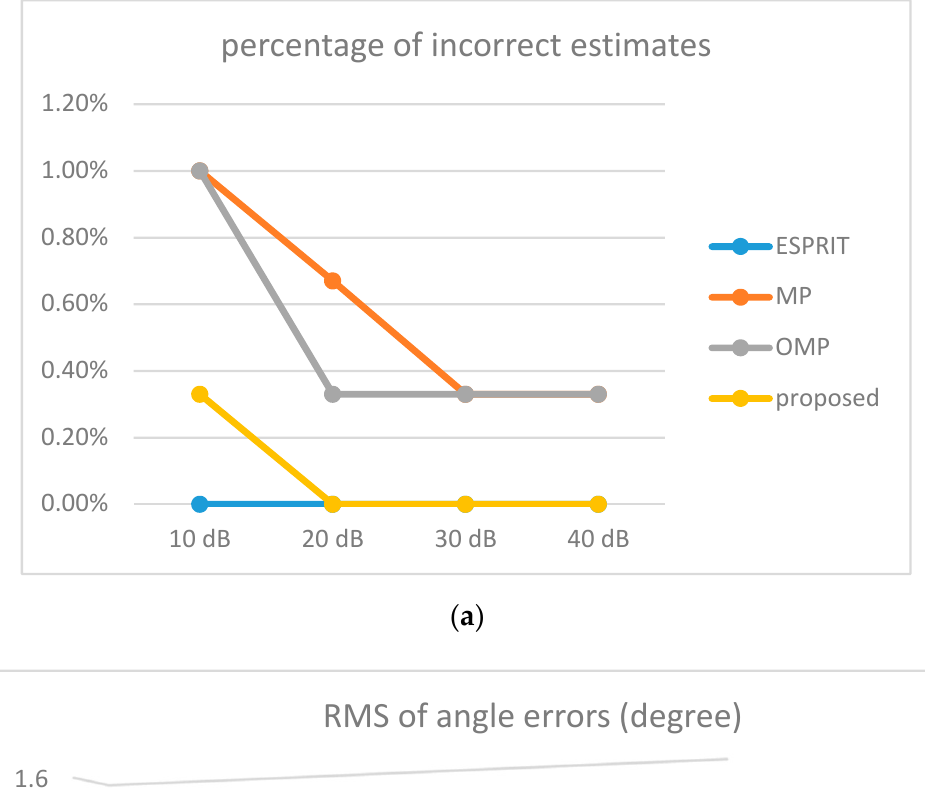
Figure 6. Estimation performance comparisons for K = 3 using codebook version 1 (M = 19 and 5° angular resolution).